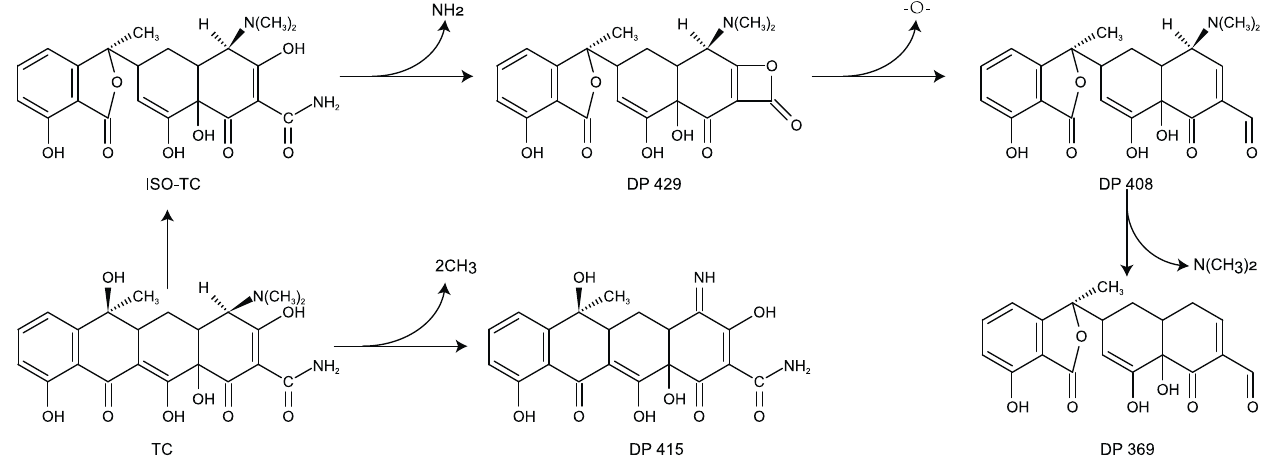
Figure 4. Putative degradation pathways of TC by strain M503.